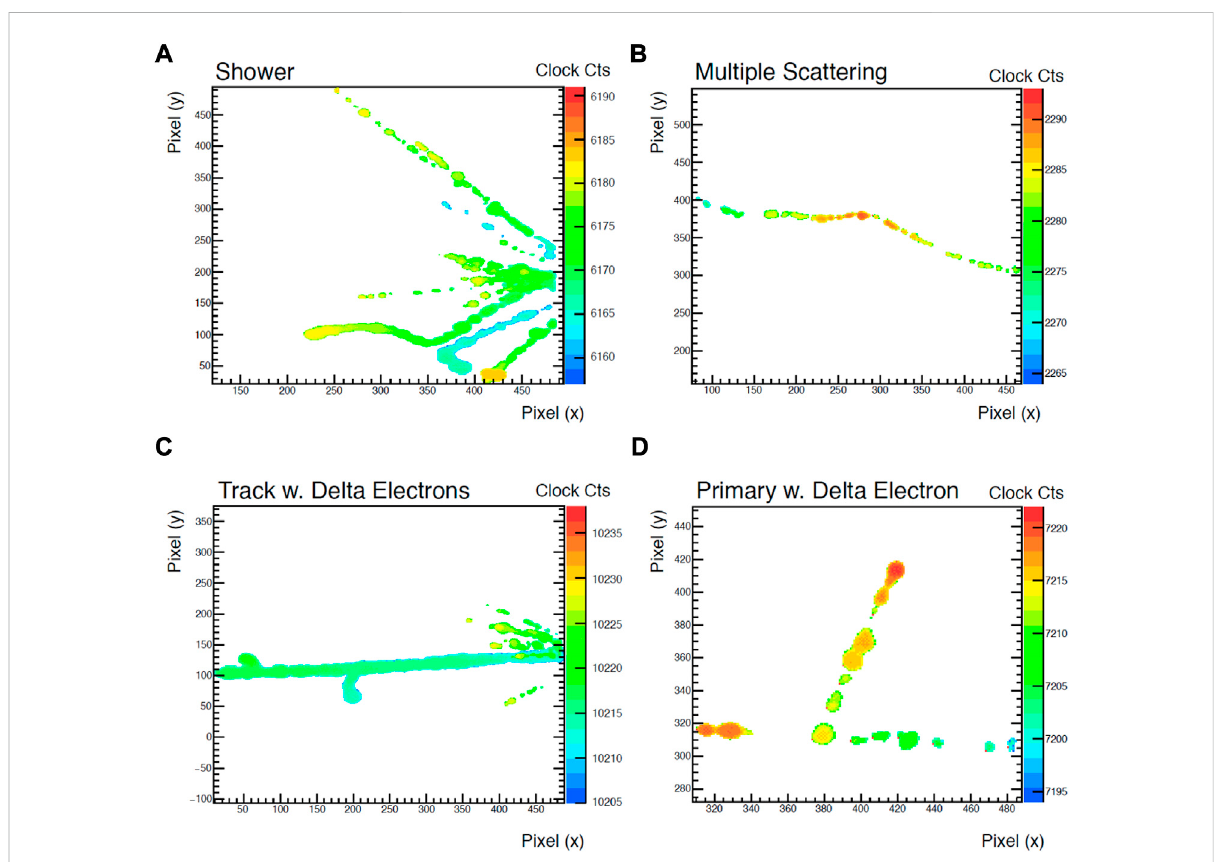
FIGURE 5 Examples of tracks measured by the GEMpix in its “ time of arrival ” mode: (A) shows a shower of secondaries, most likely originating in the TEPC wall, (B) shows a multiple scattering, (C) shows a densely ionised track (most likelya light ion) and delta electron emission, (D) shows a primary beam particle emitting an energetic delta-electron. Source: